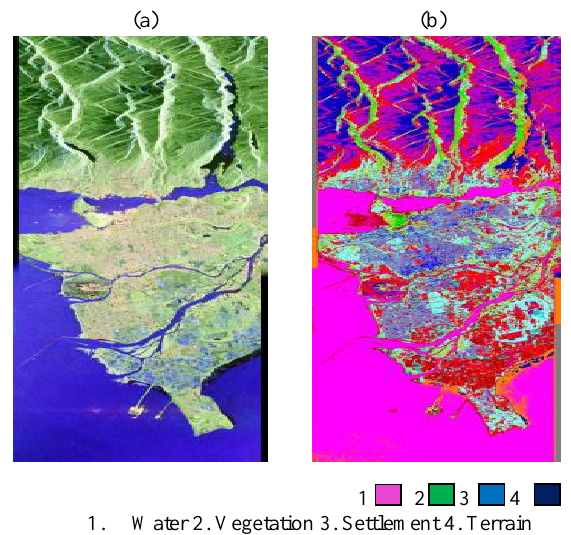
Figure 2. (a) Entropy (H) (b) Anisotropy (A) (c) Alpha (α)image for Vancouver, Canada RADARSAT-2 SAR image